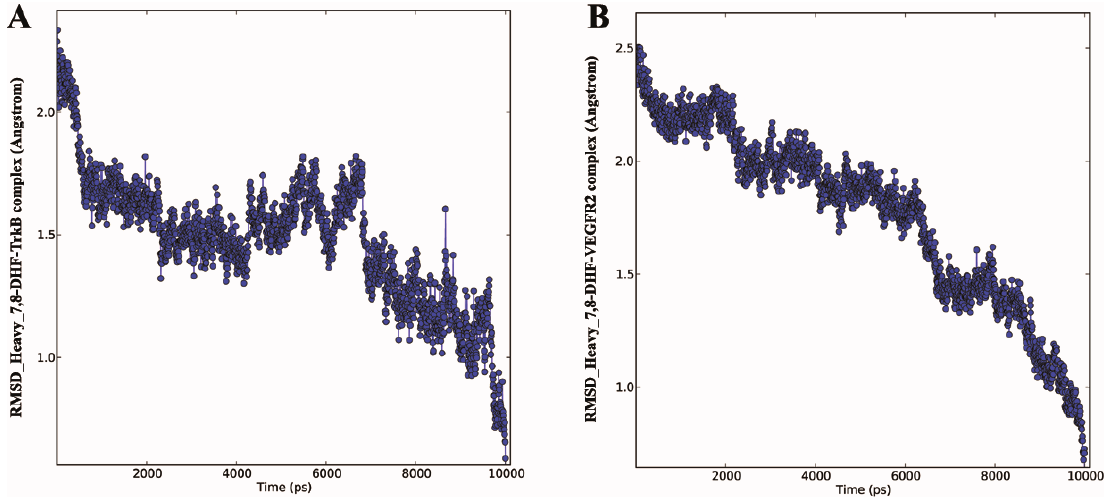
Figure 5. MD simulation time vs. RMSD of the heavy atoms. ( A ) 7,8-DHF-TrkB protein complex; ( B ) 7,8-DHF-VEGFR2 protein